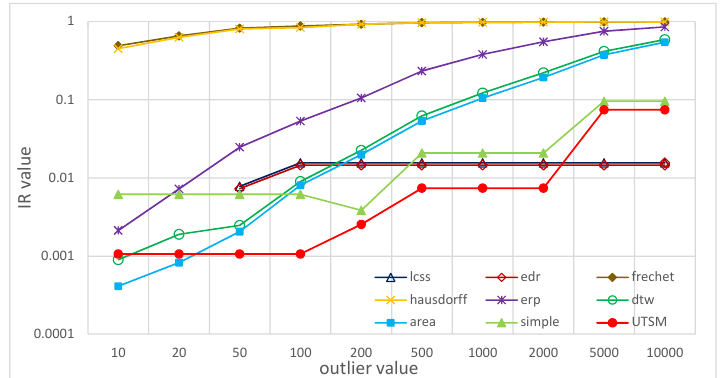
Figure 14. Influence Ratio (IR) under different outlier